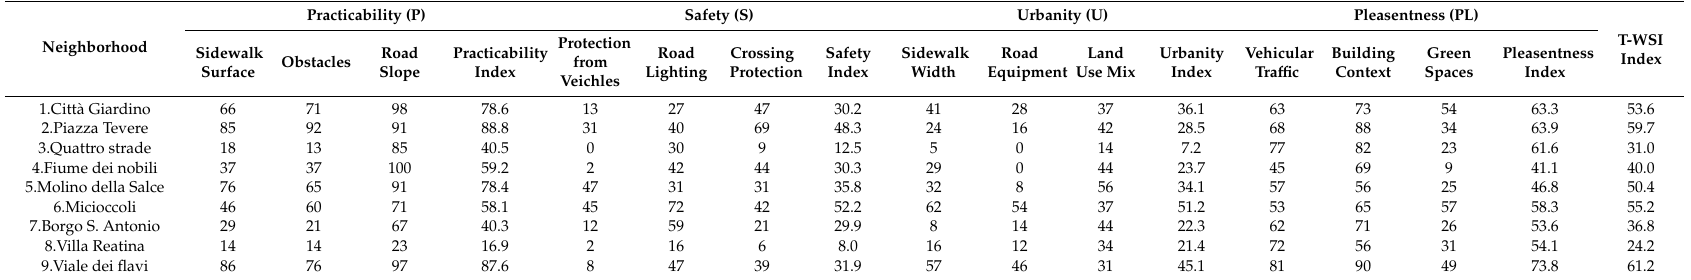
Table 2. Average results of indicators, indexes and the Walking Suitability Index of the territory (T-WSI) obtained in each neighborhood in the investigation performed in 2016.